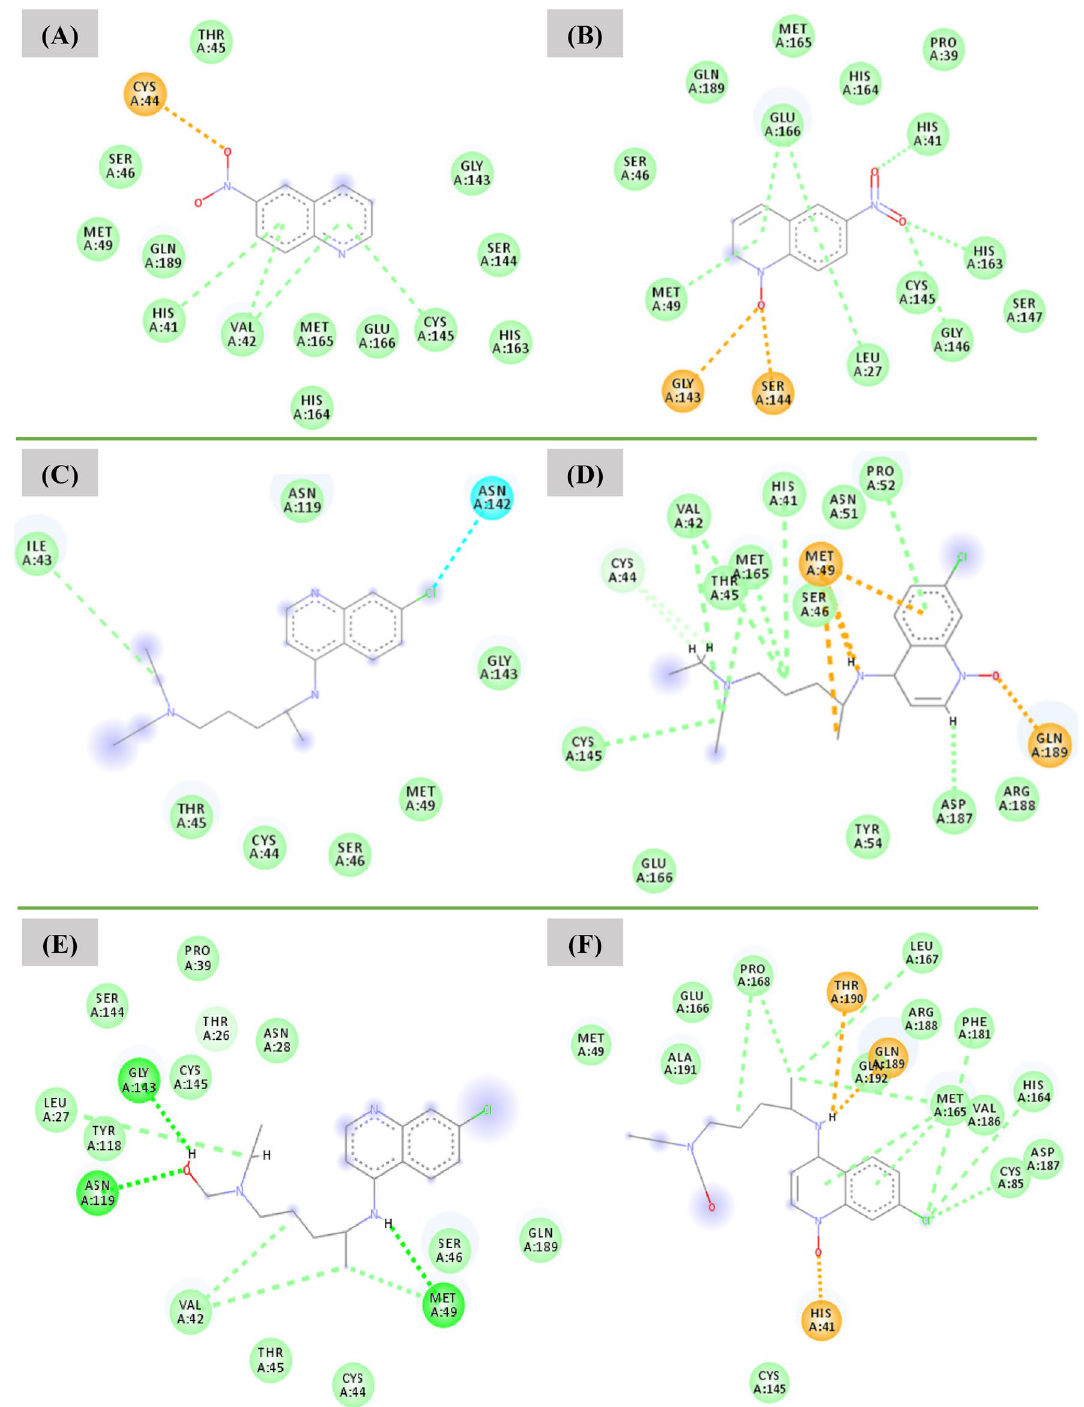
Figure 5. Interactions performed during 20 ns in the MD simulation with the ( A ) M pro /N-4-Q, ( B ) M pro /N- 4-QO, ( C ) M pro /CQ, ( D ) M pro /CQO, ( E ) M pro /HCQ, ( F ) M pro /HCQO complexes. Image generated in the Discovery Studio Software 4.5 https:// disco ver. 3ds. com/ disco very- studio- visua lizer- downl